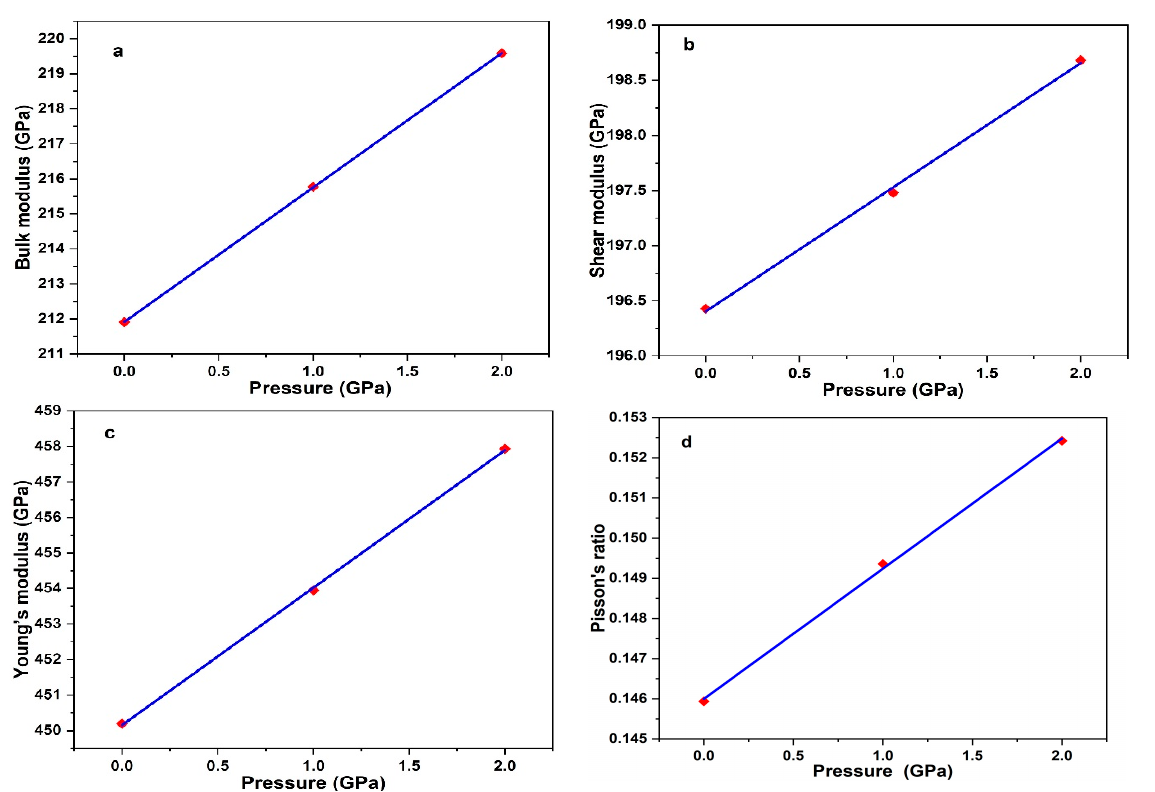
Figure 11. Mechanical properties of 3C-SiC based on different pressures; bulk modulus ( a ), shear modulus ( b ), Young’s modulus ( c ) and Poisson’s ration ( d ).